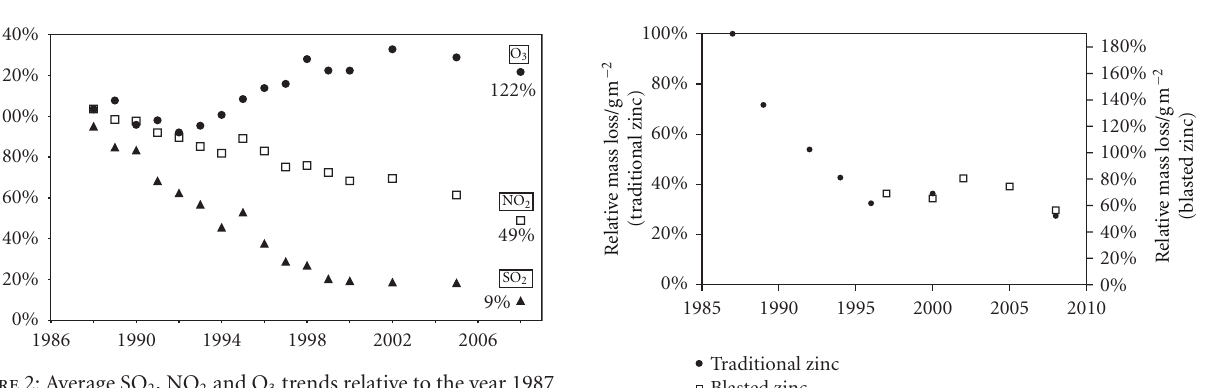
Figure 2: Average SO 2 , NO 2 and O 3 trends relative to the year 1987 at ICP Materials test sites.